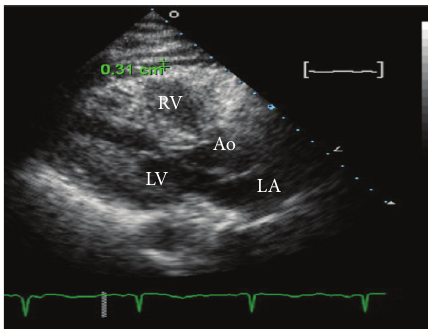
Figure 6: Echocardiographic evidence of pericardial effusion (mea- suring 0.31cm) after aortic dissection on parasternal long axis view. Ao = aorta, RV = right ventricle, LV = left ventricle, and LA = left